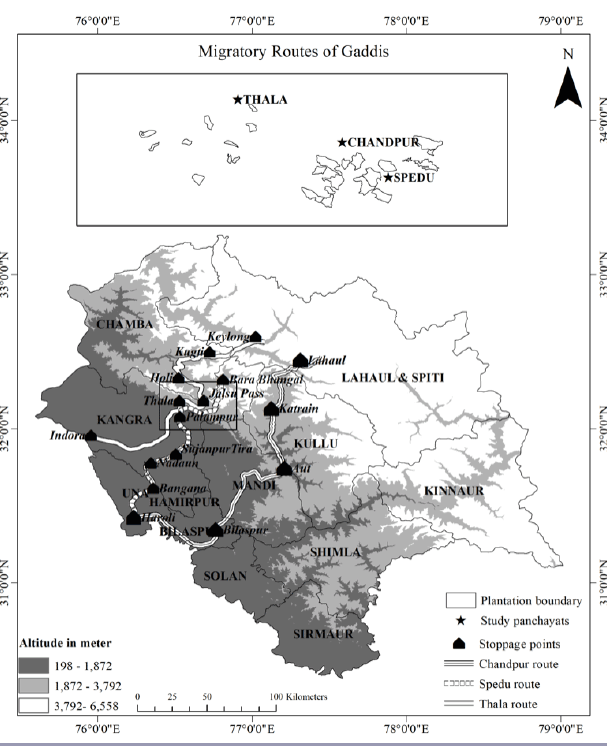
Fig. 2 . Map of study area in Himachal Pradesh, India. Fig. 3 . Map of migratory routes of Gaddis and plantations in study